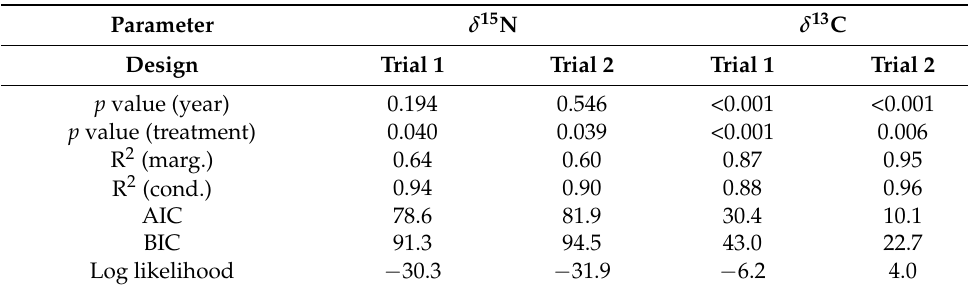
Table 4. Summary data obtained of the linear mixed model ANOVA for stable isotope ratios of N and C in oat grains produced during 2016–2017. Parameter δ 15 N δ 13 C